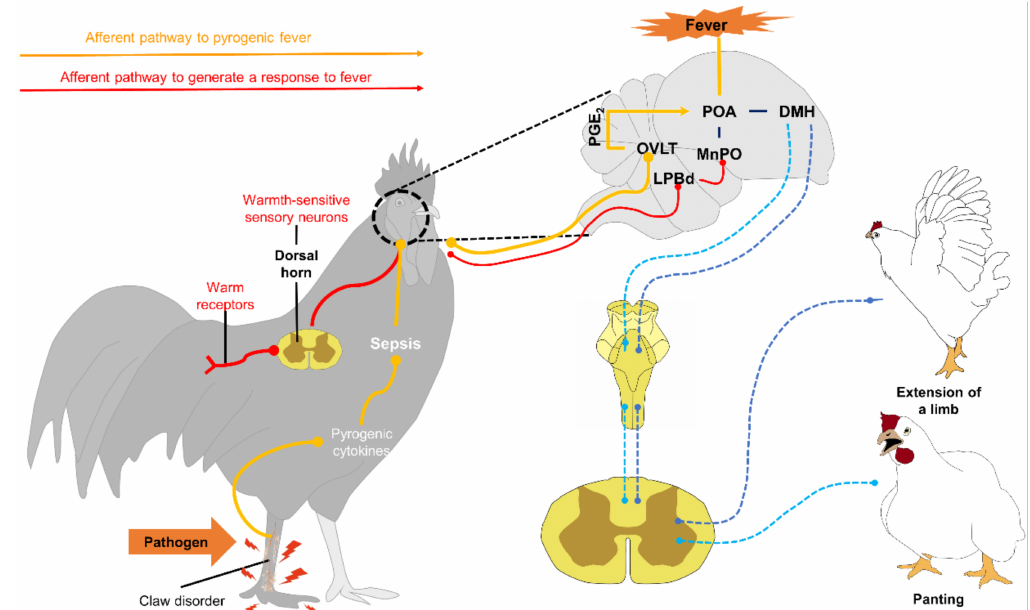
Figure 5. Neurophysiological mechanism for the development of behavioral responses in birds with a febrile process. A hen is shown with a foot lesion that facilitates the entry of a pathogen into the body. The presence of the pathogen leads to the production of pyrogenic cytokines, which, upon reaching the bloodstream, generate sepsis. When these cytokines interact with the organum vasculosum of the lamina terminalis (OVLT), the synthesis of prostanoids, such as PGE2, is stimulated, and they act at the POA level, decreasing the activation speed of heat-sensitive neurons, causing the onset of the febrile process. Subsequently, the thermoreceptors detect the increase in temperature and transmit that signal to the dorsal horn of the spinal cord, where warmth-sensitive sensory neurons are activated. These neurons emit an ascending signal that reaches the lateral parabrachial nucleus of the dorsal subregion (LPBd), which emits a glutamatergic projection to the median preoptic nucleus (MnPO). Once the information is transmitted to the POA, the dorsomedial nucleus of the hypothalamus (DMH) sends an impulse, so that, through still unknown efferent pathways (broken lines), behavioral responses such as panting and extension of a limb are generated to dissipate excess